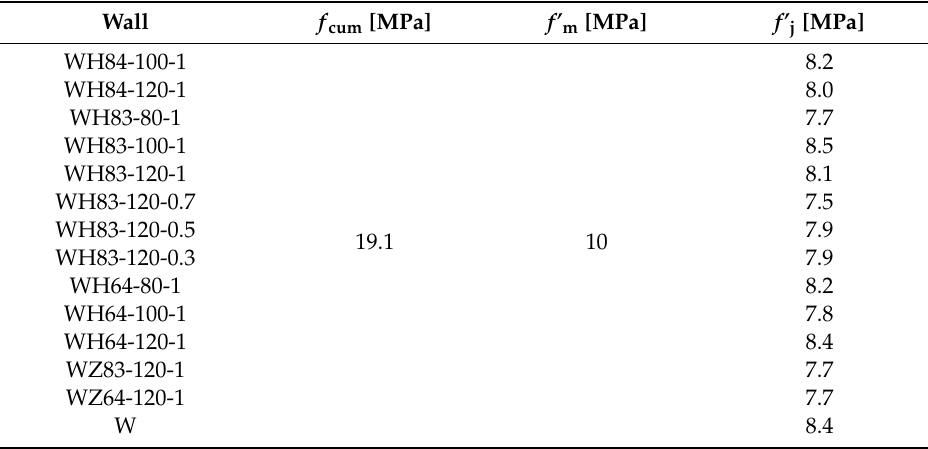
Figure 6. Loading history.